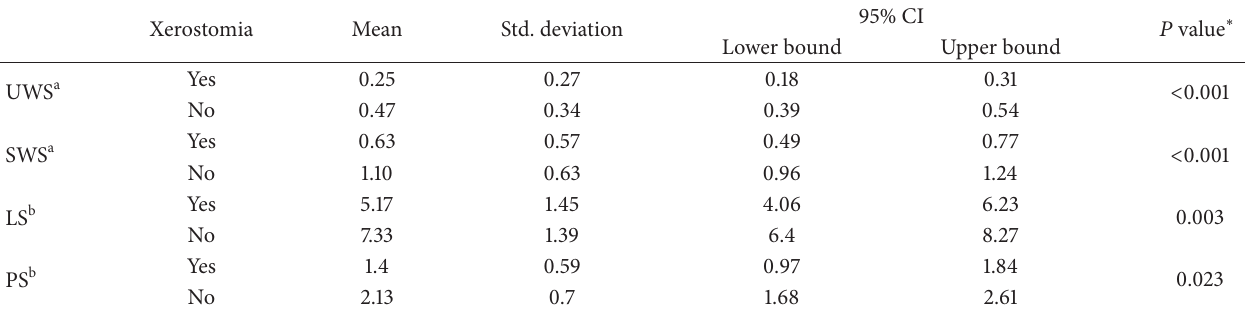
Table 3: Salivary flow rates between subjects with and without xerostomia complaint.